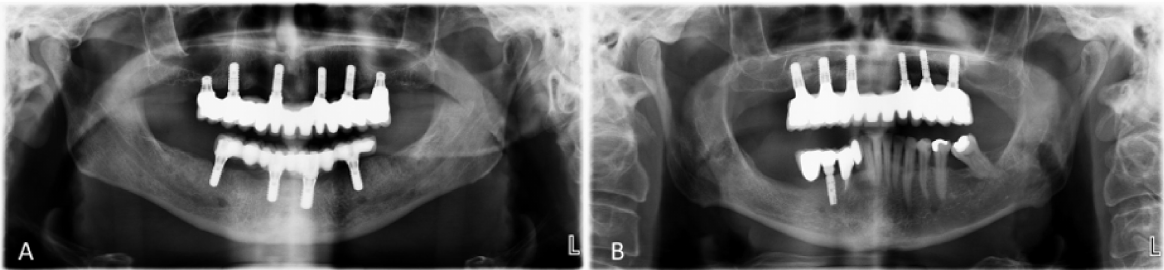
Figure 1. Panoramic X-ray after treatment. Short ( A ) and control implants ( B ) were loaded with fixed full-arch fixed dental prostheses (FDPs). Bilaterally, the most posterior implants were 4 mm long ( A ) or 10 mm long ( B ) that were installed after sinus floor augmentation.